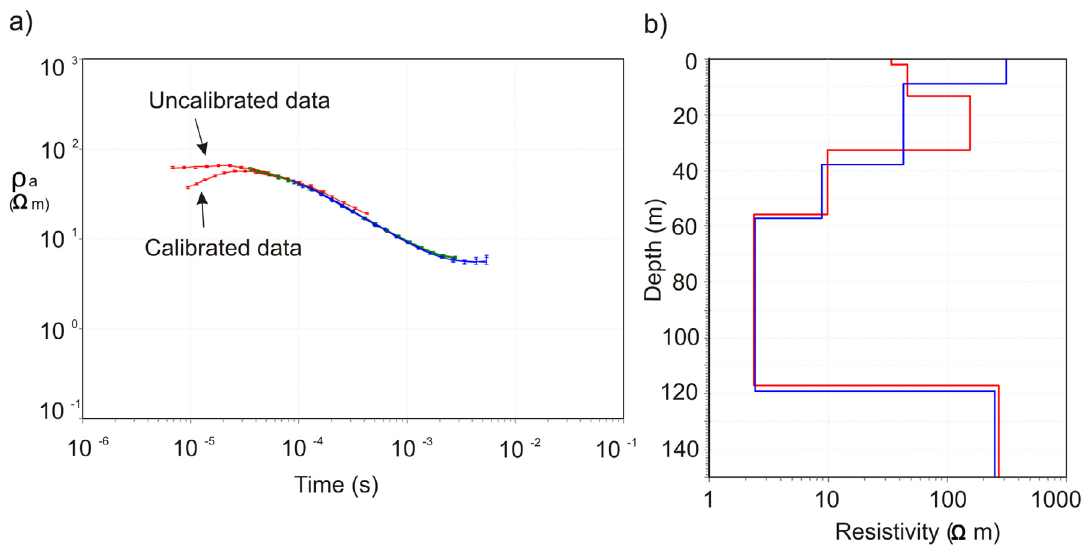
Figure 3. INGV Geonics 47 data calibrated at the Lyngby test site (Denmark). (a) Un-calibrated and calibrated forward responses. Error bars are the observed data while the colored lines are the forward responses respectively for the ultra high (UH, red curve), very high (VH, green curve) and high (Hi, blue curve) segments of the transient curve. Note that the Danish reference response match with the newly calibrated Geonics forward response. (b) 1-D resistivity models. Blue curve is the 1-D resistivity model recovered from the Geonics 47 data before the calibration. Red curve shows the 1-D reference resistivity